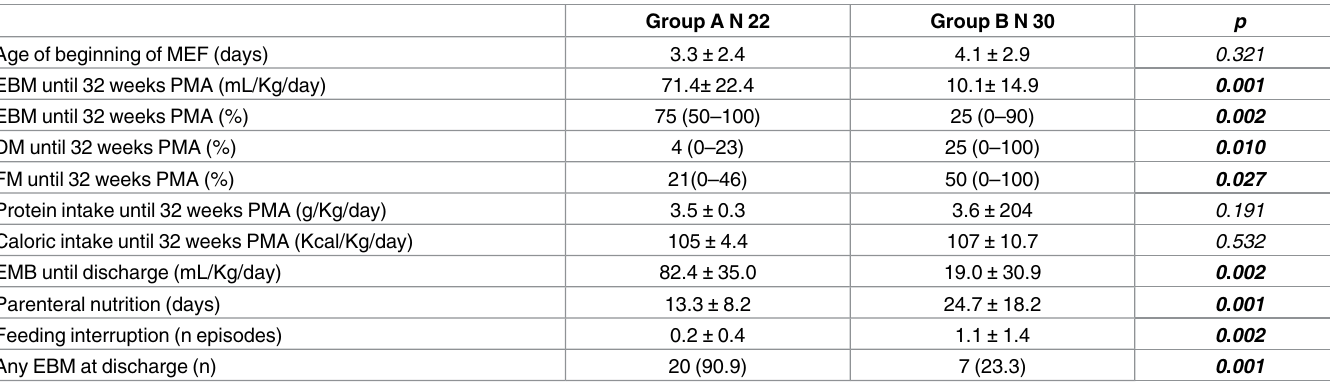
Table 2. Nutritional